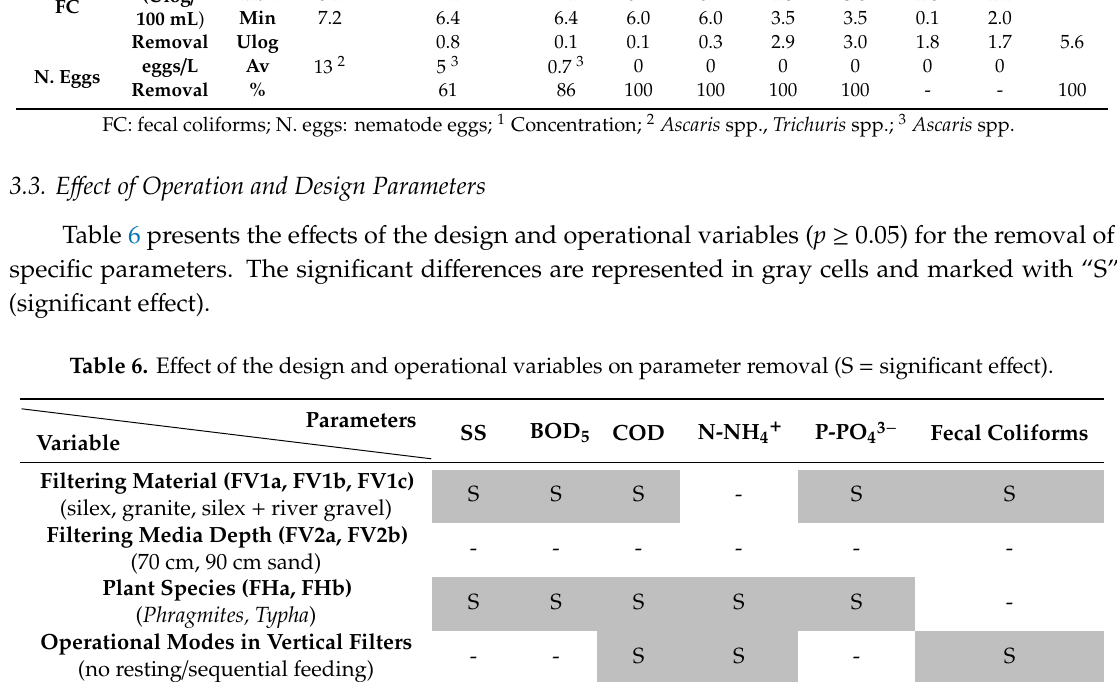
Operational Modes in Vertical